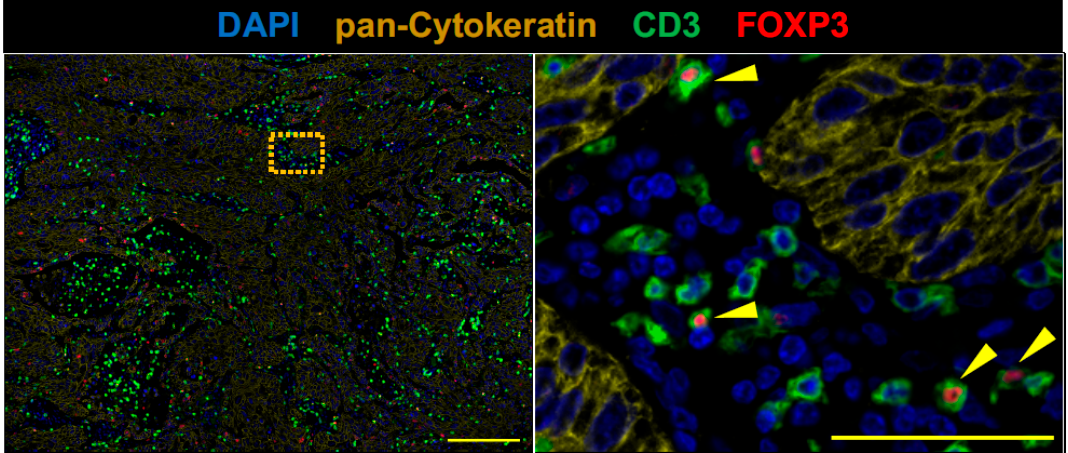
Figure 4. FOXP3+ CD3+ T cells (Tregs) sparsely infiltrate pretreatment lung tumor. Serial FFPE sections were stained with antibodies against CD3 (green), FOXP3 (red), and pan-Cytokeratin. The right panel show the boxed region in the left panel at high magnification. Tregs were sparsely infiltrated in this tumor tissue. Scale bars, 200 µ m (left panel), and 50 µ m (right panel) are shown in each